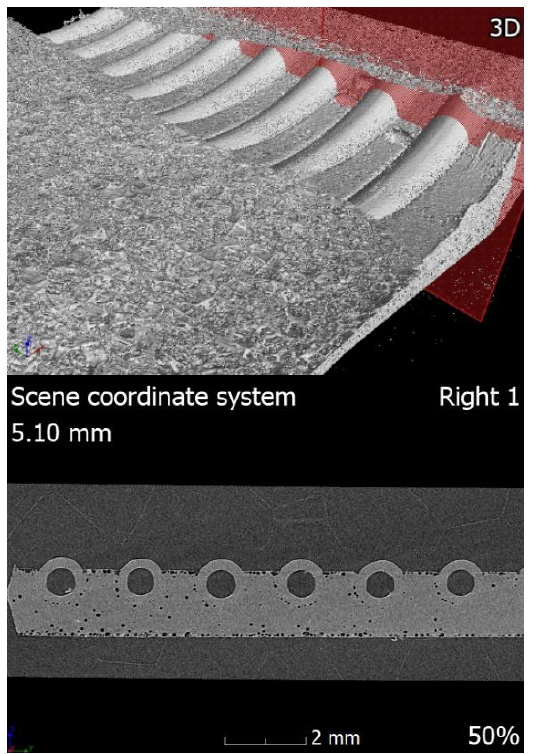
Fig. 5. A detailed view of the 3D CT scan of the heat exchanger, in which the fibers protrude outside the PDCPD matrix (top) and the planar section showing an intact wall thickness of the fibers (bottom).